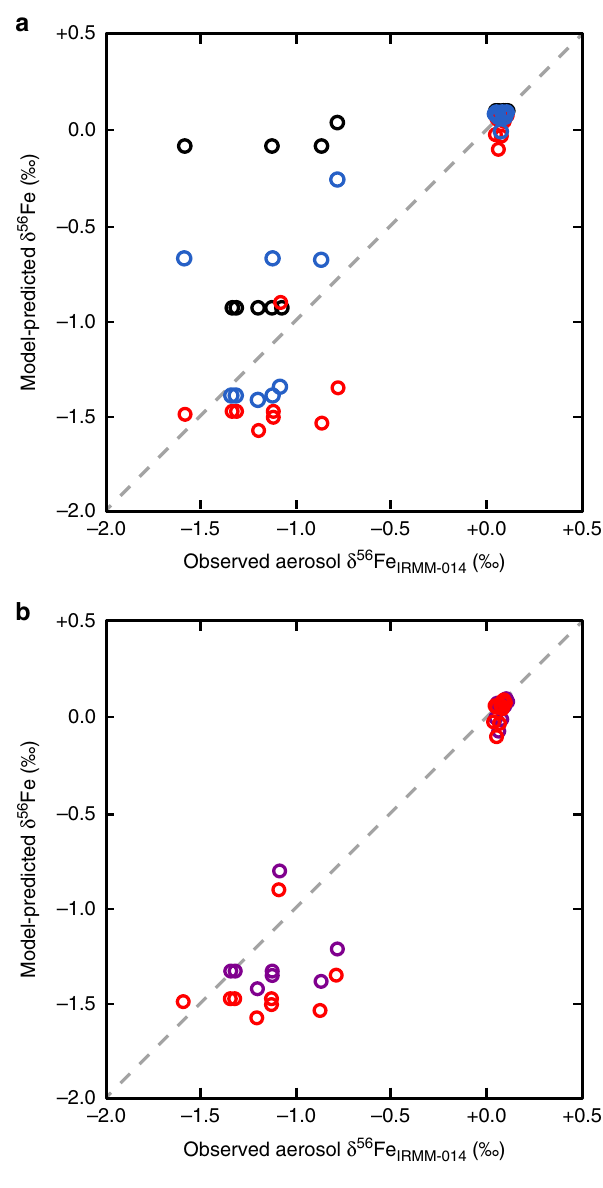
Fig. 5 Comparison of GA03 observations with model predictions. Black circles denote output from CAM4 baseline model scenario of Scanza et al. 49 with monthly average output and end members of + 0.09 ‰ for dust and − 1.6 ‰ for anthropogenic Fe, and shows poor agreement. In a , agreement is improved by changing model to use daily mineral dust to capture dust storms and reduced dust source solubilization (from 25 to 10%) (blue circles). Agreement is further improved in a by using 5× anthropogenic emissions, to generate an isotope-re fi ned model scenario (CAM4 isotope-re fi ned scenario) which best matches GA03 observations (red circles). The anthropogenic endmember was also optimized in b to provide best fi t between model and observations (see main text; red points are with an anthropogenic δ 56 Fe endmember of − 1.6, purple circles are with an optimized anthropogenic δ 56 Fe endmember of − 1.4 ‰